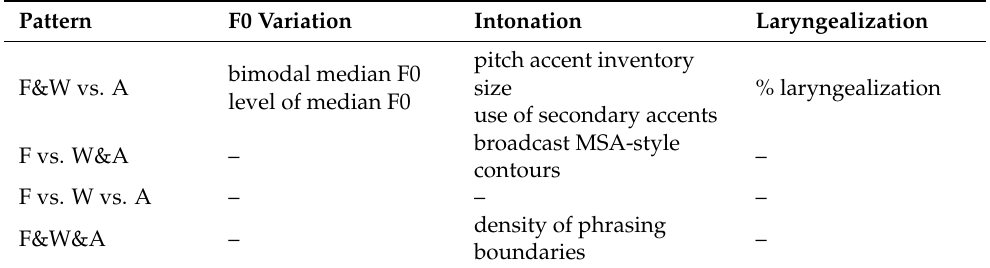
Table 8. Summary of observed variation in differentiation of registers, by prosodic feature type.